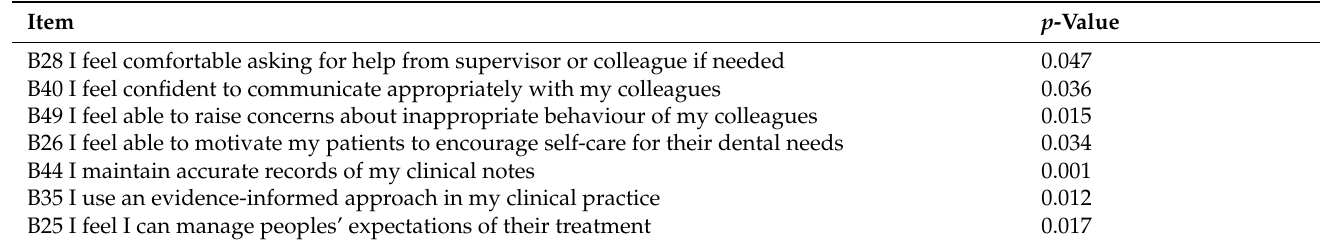
Table 5. Association between Institution Category and Item Responses for Part B Specific p -values from Chi-Squared tests of association for items showing a statistically significant association between Institution Category and Item Responses for Part